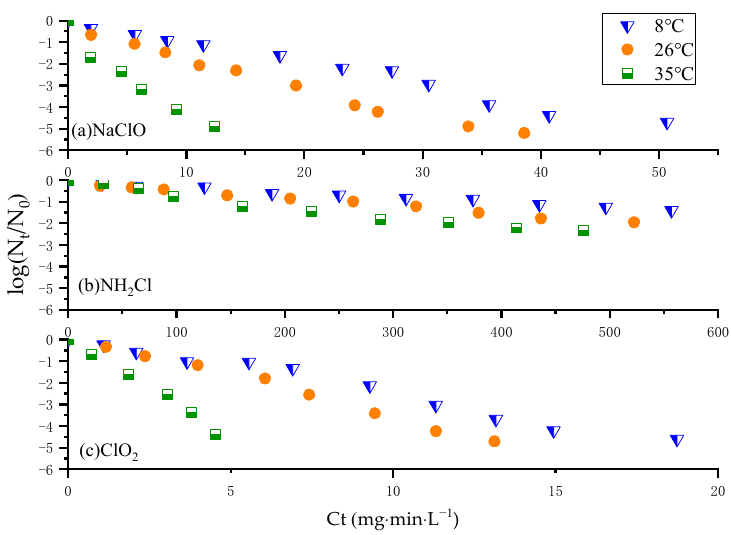
Figure 6. Inactivation effect on N. europaea using ( a ) free chlorine, ( b ) monochloramine and ( c ) chlo- rine dioxide at varying temperatures. Experiments were conducted within the target disinfectant concentration of 1 mg · L − 1 Cl 2 . The disinfectant susceptibility of N. europaea was analyzed at 8 ◦ C, 26 ◦ C and 35 ◦